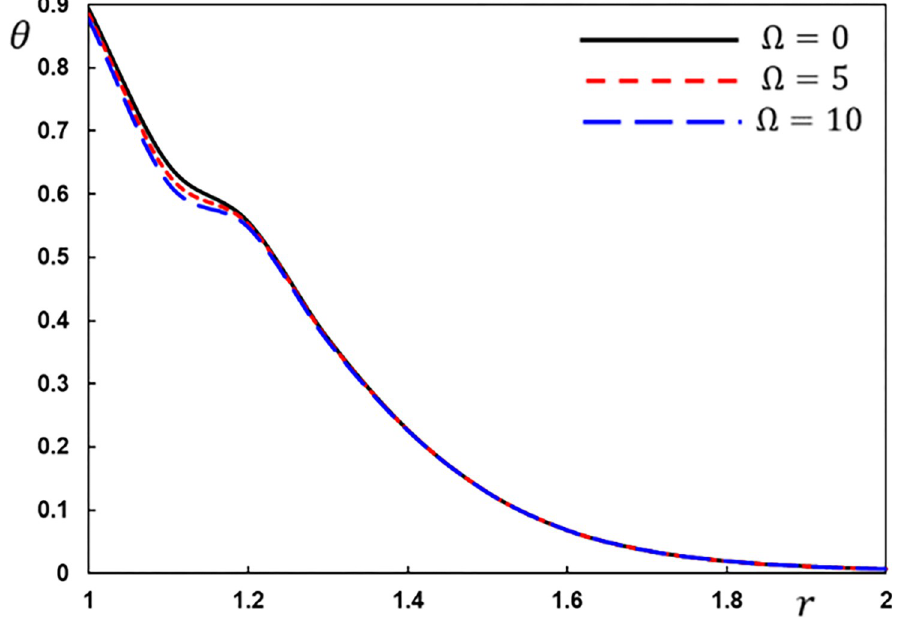
Fig 5. The temperature variation θ for different values of the rotation speed O